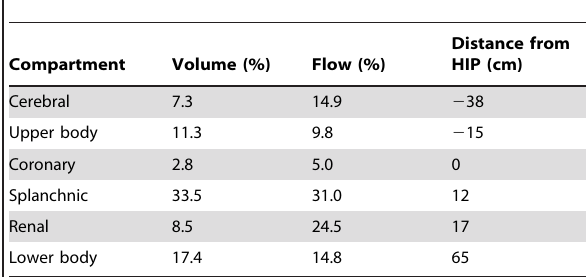
Table 1. Flow and volume distributions in each of the six vascular compartments during supine position, as well as their respective distances from the hydrostatic indifference point